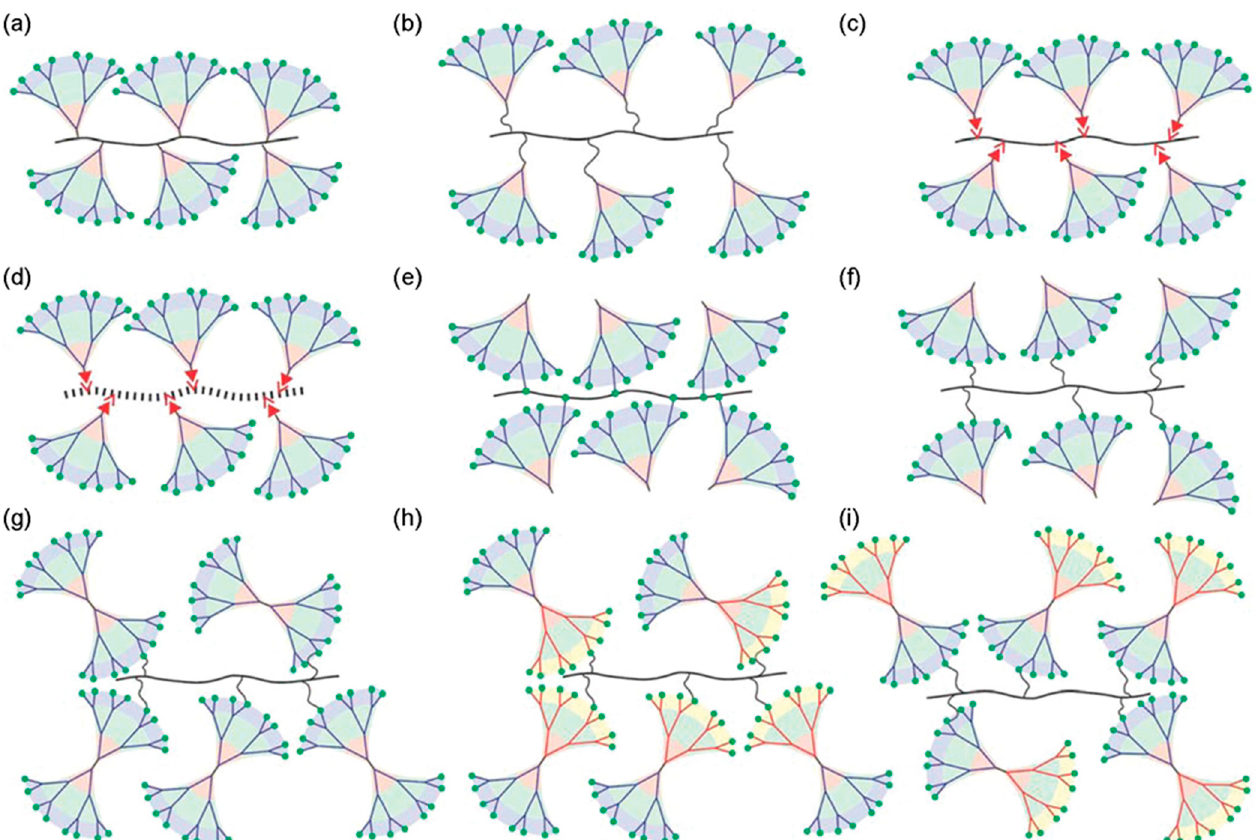
Figure 14. The diversity of possibilities for the attachment of a self-assembling dendron or den- drimer to a covalent or supramolecular backbone. Topologies generated from linear covalent and supramolecular polymers dendronized with self-assembling dendrons, twin dendritic molecules, and Janus dendrimers [185]. Dendron directly attached to the polymer backbone via apex ( a ), with a flexible spacer ( b ), attached via non-covalent interactions ( c ), supramolecular polymers dendronized ( d ), dendron directly attached to the polymer backbone via its periphery ( e ), via its periphery and a flexible spacer ( f ), covalent polymers dendronized with twin-dendrimers ( g ), and with Janus den- drimers ( h , i ). This Figure is reproduced with permission from [185]. Copyright © 2012, American Chemical